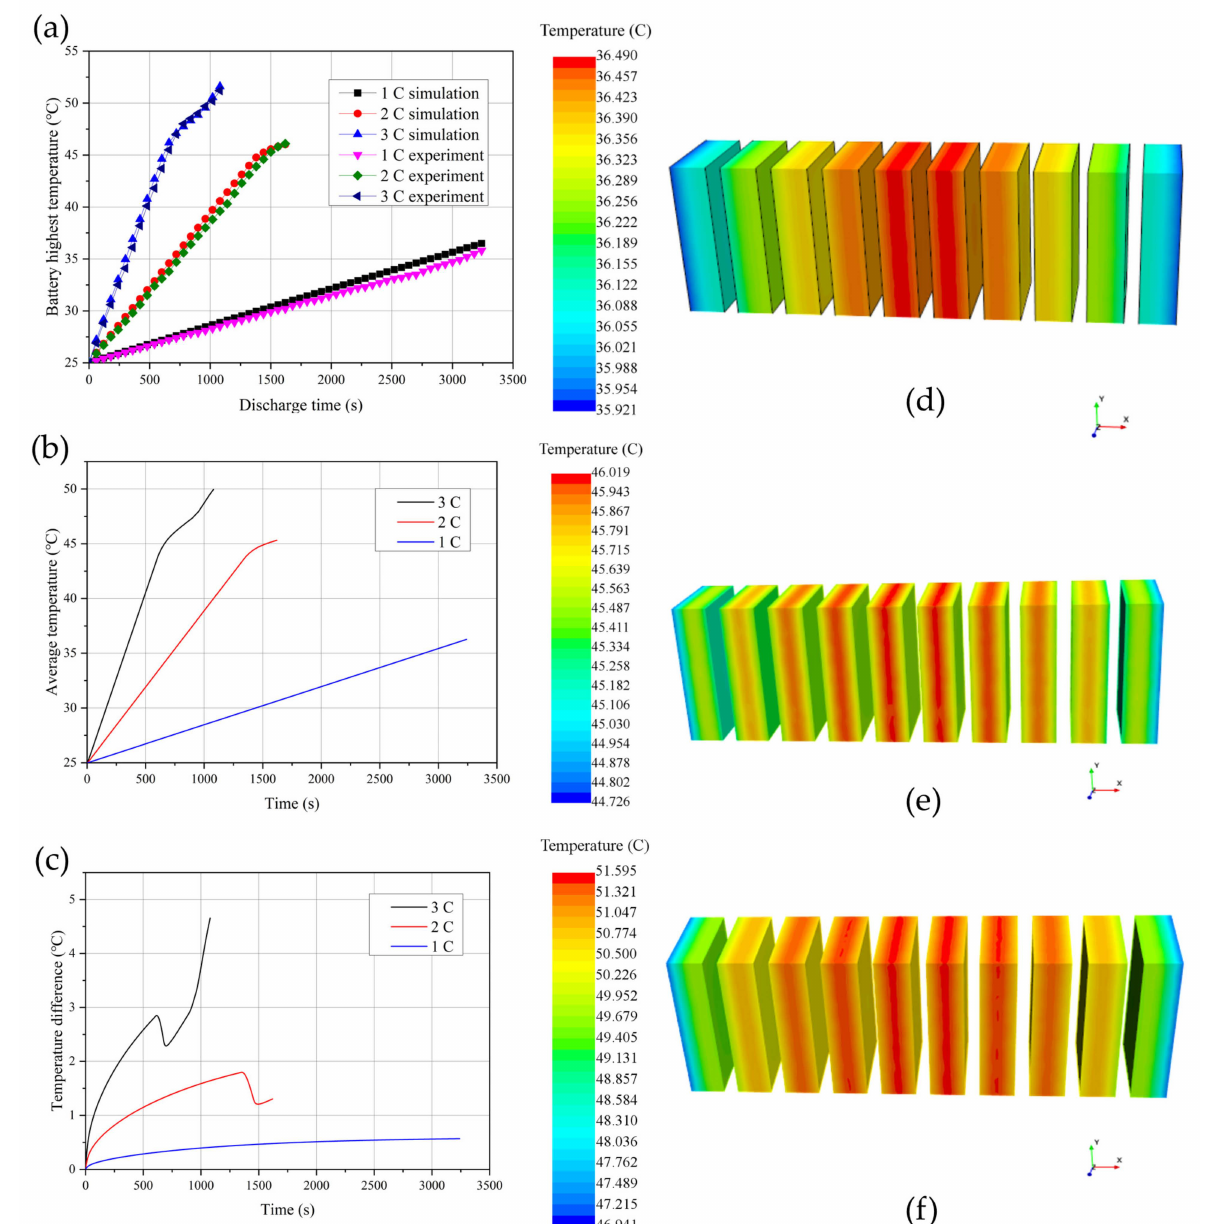
Figure 7. Temperature rise curve of non-fins PCM container cooling system at different discharge rates: ( a ) maximum temperature; ( b ) average temperature; ( c ) temperature difference. Simulation result of temperature field diagram of the battery pack with a non-fin PCM container at the discharge time t: ( d ) 1C, t = 3240 s; ( e ) 2C, t = 1620 s; ( f ) 3C, t = 1080